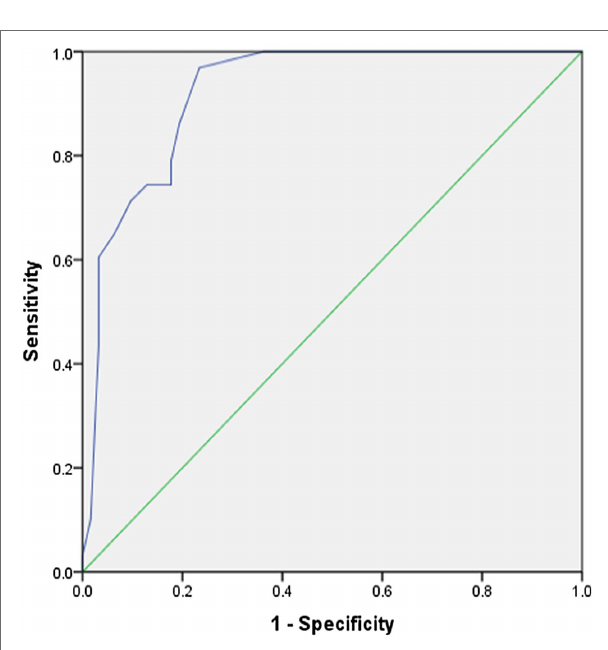
FIGURE 2 | Receiver operating characteristic (ROC) curve (gender).